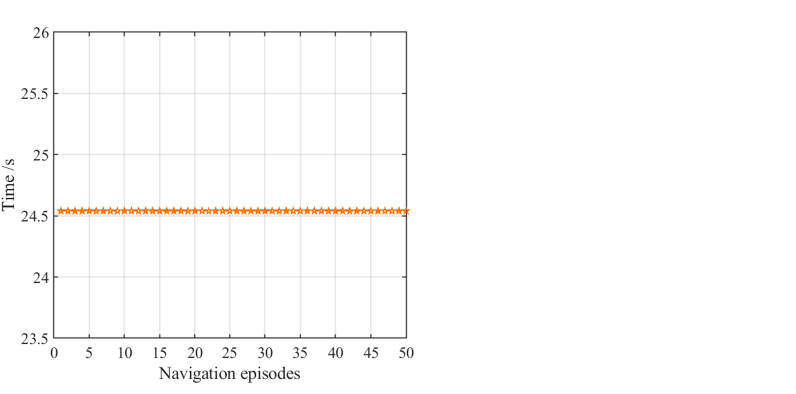
Figure 9. Navigation time with the hippocampal model alone. Orange pentagrams indicate the navigation time for each navigation episode.